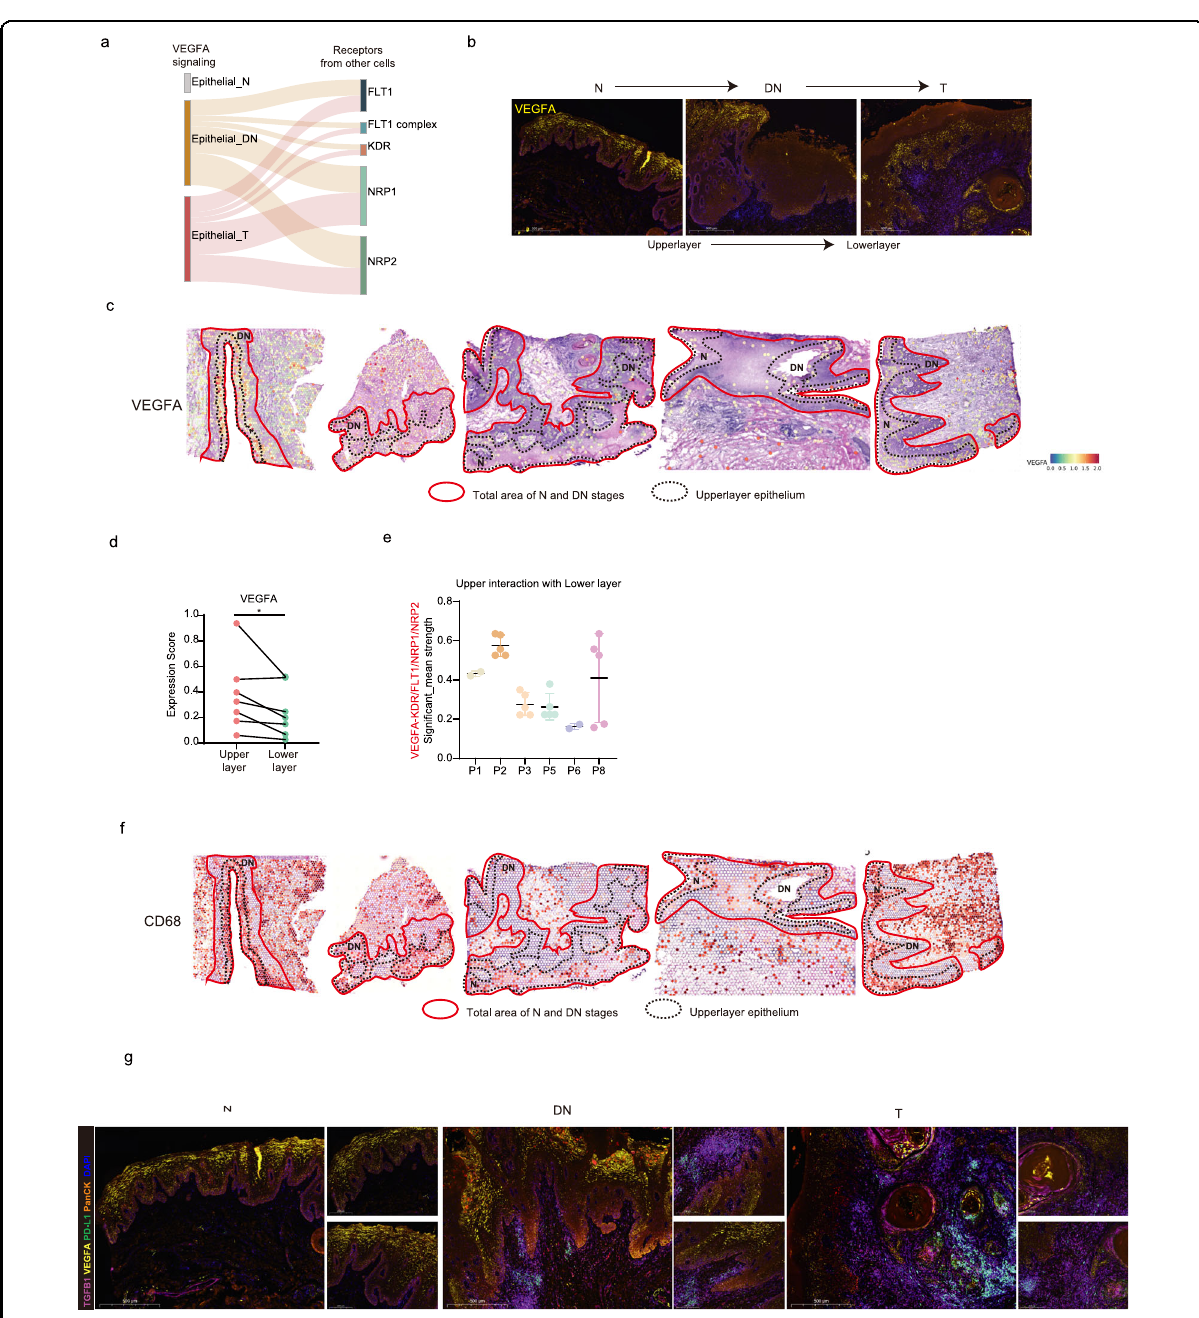
Fig. 6 Spatial distribution of VEGF signaling during cancer initiation. a Alluvial plot showing selected VEGFA – NRP1/NRP2/KDR/FLT1 interactions between different initiation stages of epithelial cells and other cell subclusters. b mIHC staining of VEGFA in one patient of diverse initiation stages. Scale bars: 500 μ m. c ST feature plots showing the expression of VEGFA in different distributions. Red solid lines circled total epithelium region of N and DN stages; black dotted lines indicated the upper layer of epithelium, mainly composed of differentiated keratinocytes. d Quantitative scores of expression levels of VEGFA in upper and lower layer of the corresponding ST sections. A two-tailed paired Student ’ s t- test for the P values. * P < 0.05. e Scores of VEGFA-NRP1/NRP2/KDR/FLT1 interactions between the upper layer and lower layer of epithelium in diverse ST sections. Signi fi cant mean and signi fi cance ( P < 0.05) were calculated based on the interaction and the normalized cell matrix achieved by Seurat Normalization. f ST feature plots showing the expression of CD68 in different distributions. Red solid lines circled total epithelium region of N and DN stages; black dotted lines indicated the upper layer of epithelium, mainly composed of differentiated keratinocytes. g mIHC staining of VEGFA, PD-L1, TGF β 1, and PanCK in one patient of diverse initiation stages. Scale bars: 500 μ